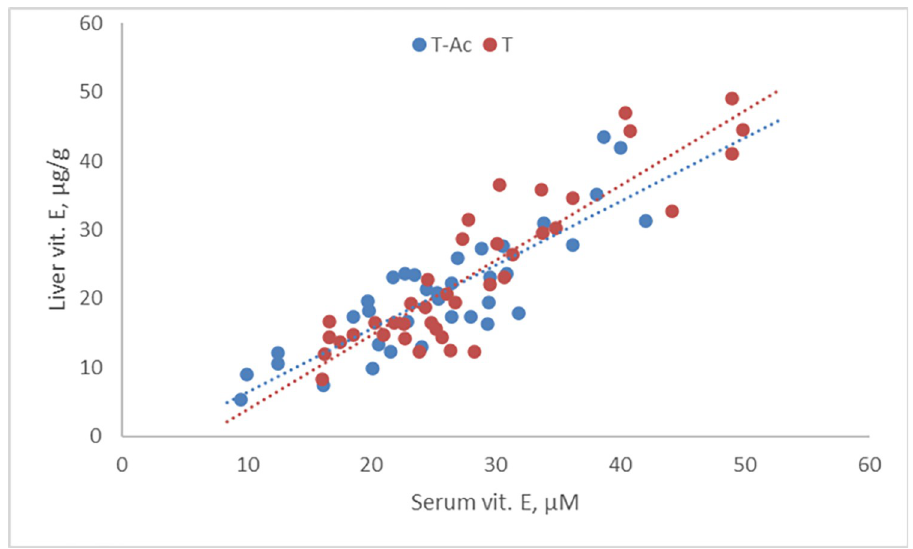
Fig 2. Comparison of serum and liver vitamin E levels for the group-housed birds. Control birds received tocopherol-acetate (T-Ac), and test birds received tocopherol (T).